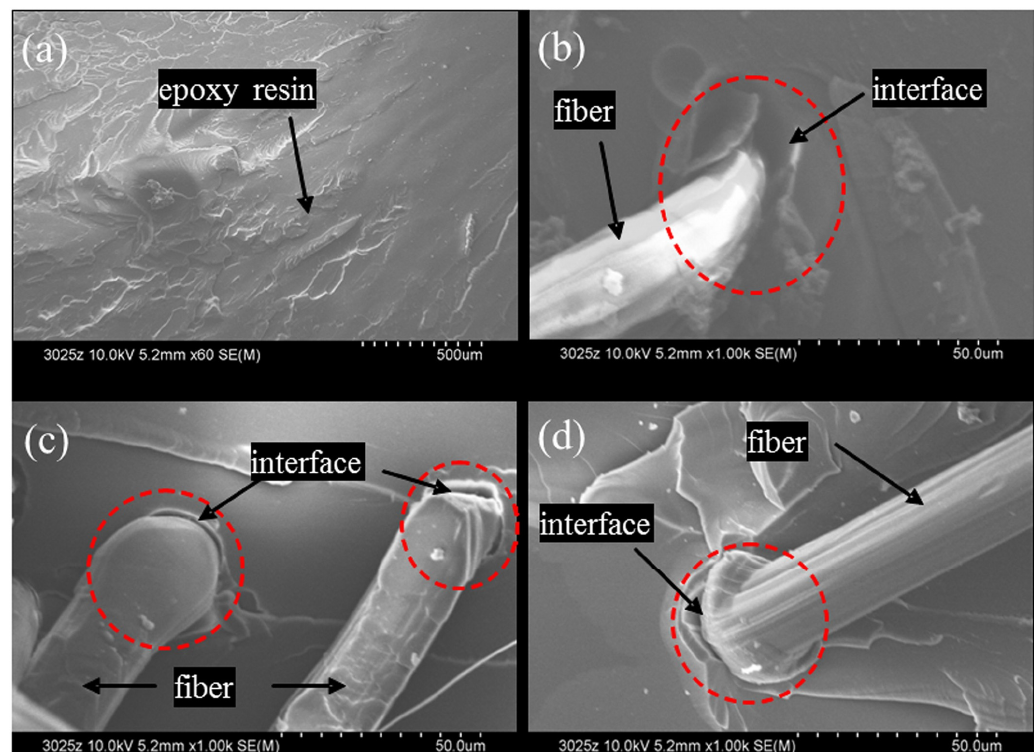
Figure 4. Scanning electron microscopy of UHMWPE fibers with tensile fracture surface; ( a ) epoxy resin, ( b ) UHMWPE-epoxy resin, ( c ) UHMWPE-PDA-epoxy resin, and ( d ) UHMWPE-PDA-HMDA- epoxy resin. Reprinted with permission from [42].